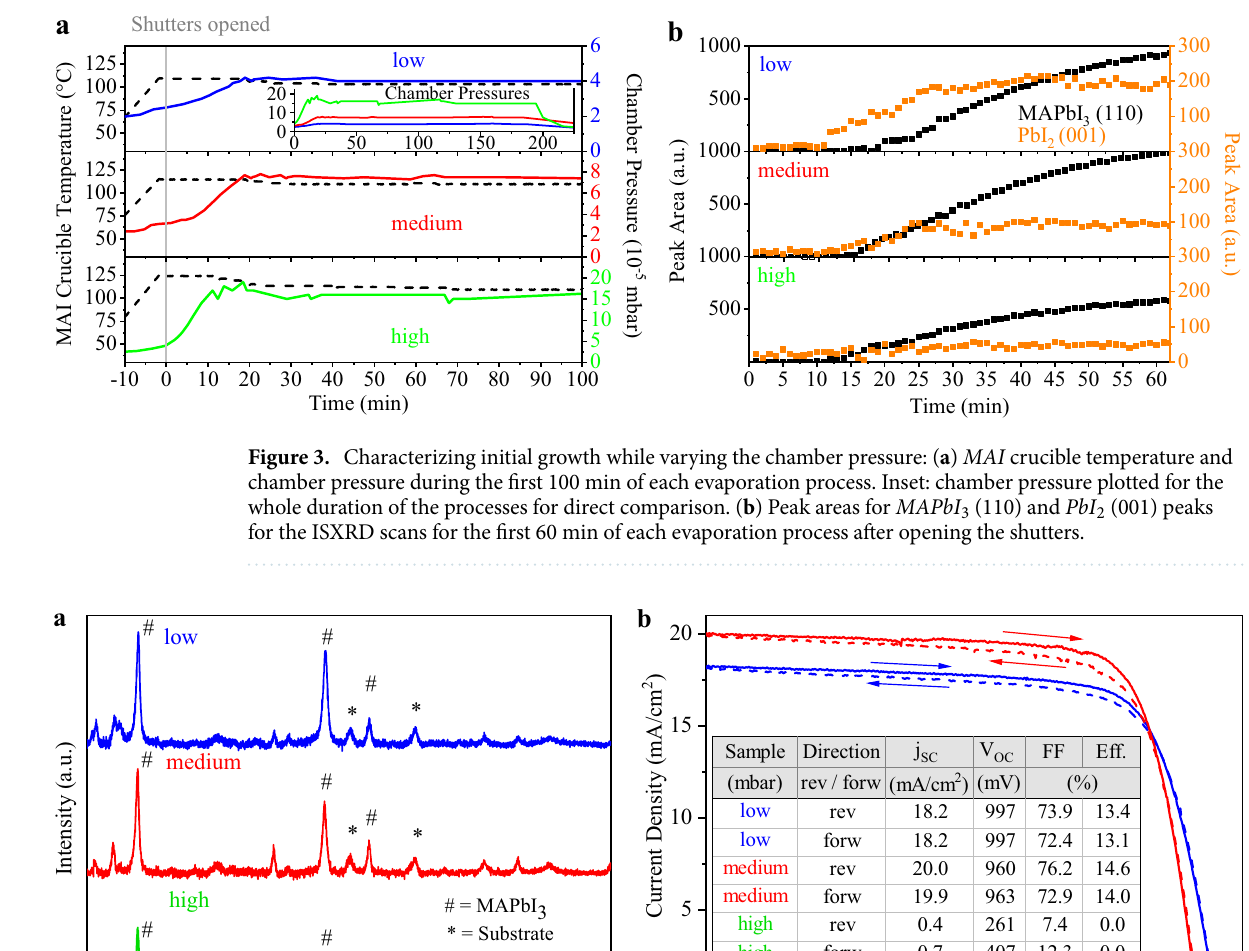
◦ ◦ ◦ , 28.2 and 31.5 , respectively. Substrate peaks